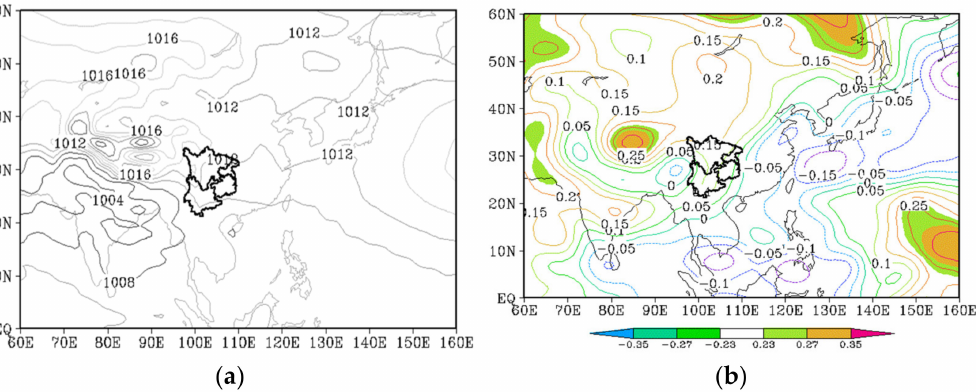
Figure 7. The sea level pressure field of rainstorms and floods in high-value years ( a ), the correlation coefficient ( b ) of rainstorms and floods and sea level pressure field in the summer half-year during 1961–2021. The shaded areas represent those where the correlation passes 90% (Green), 95% (Brown), and 99% (Rose) significance